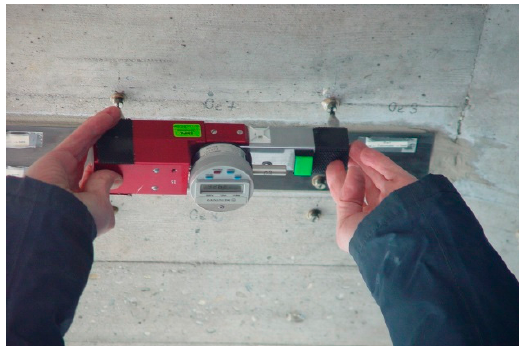
Figure 23. Mechanical strain gauge, which is used for the measurements.